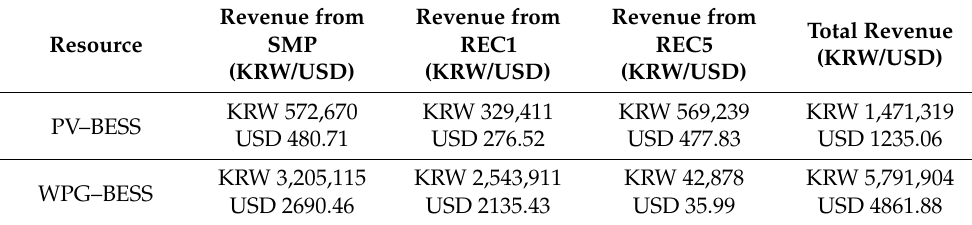
Table 11. Intraday revenue generated from the scheduling methods with profit maximization.